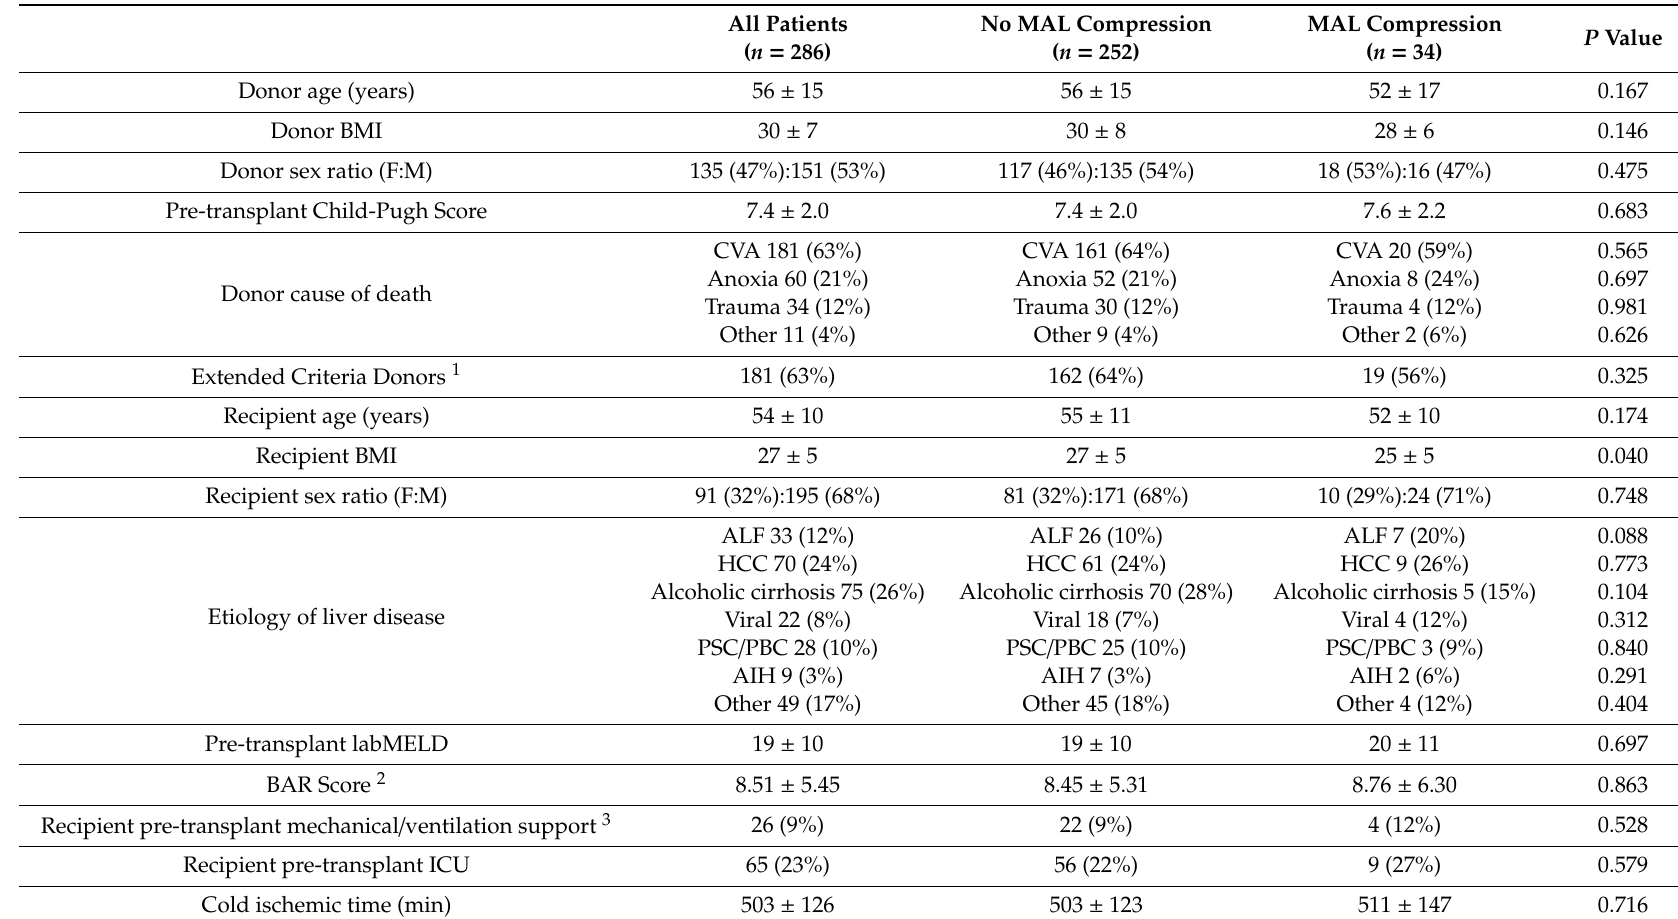
Table 2. Characteristics of patients who underwent orthotopic liver transplantation (OLT) stratified according to the presence of extrinsic stenosis of the celiac axis